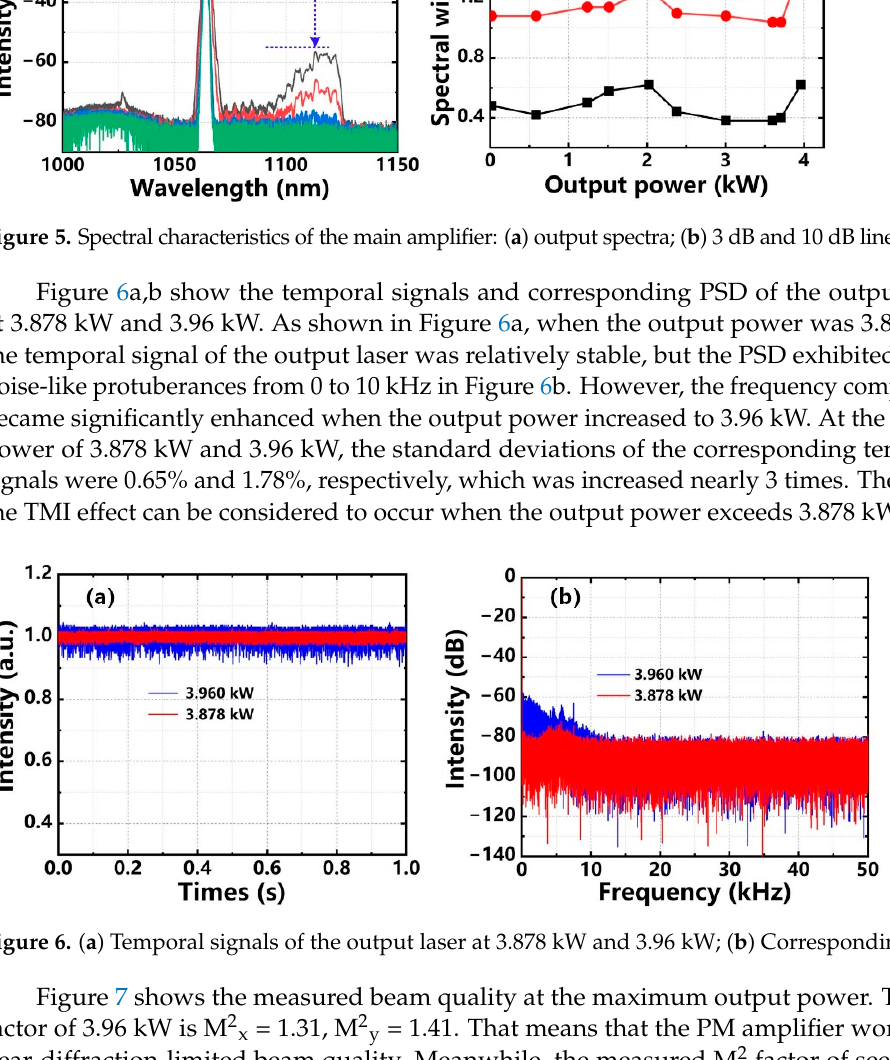
Figure 4. Output characteristics of the main amplifier: ( a ) Power curve; ( b ) PER.